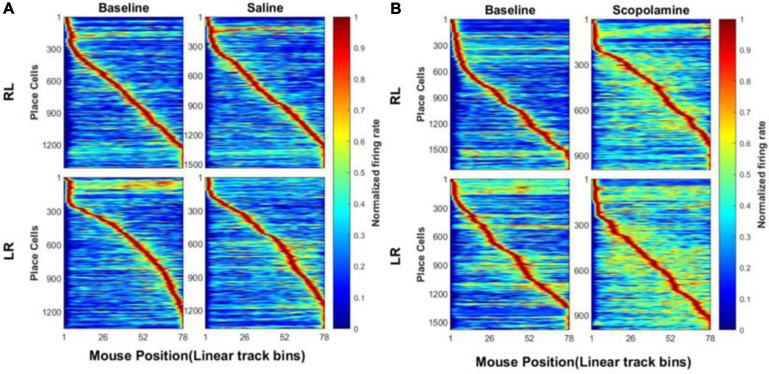
Normalised place field map (see section “Methods”) when the animals run on the linear track before and after the administration of (A) saline or (B) scopolamine (1 mg/kg) on both running directions. The bin size was 2 cm. The location sensitivity of the place cells in saline group was very stable, while it decreased considerably after scopolamine administration.